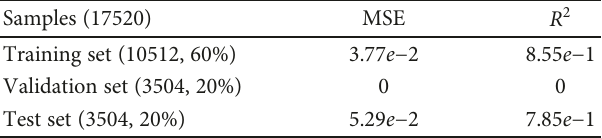
Table 2: Performance of the load forecast